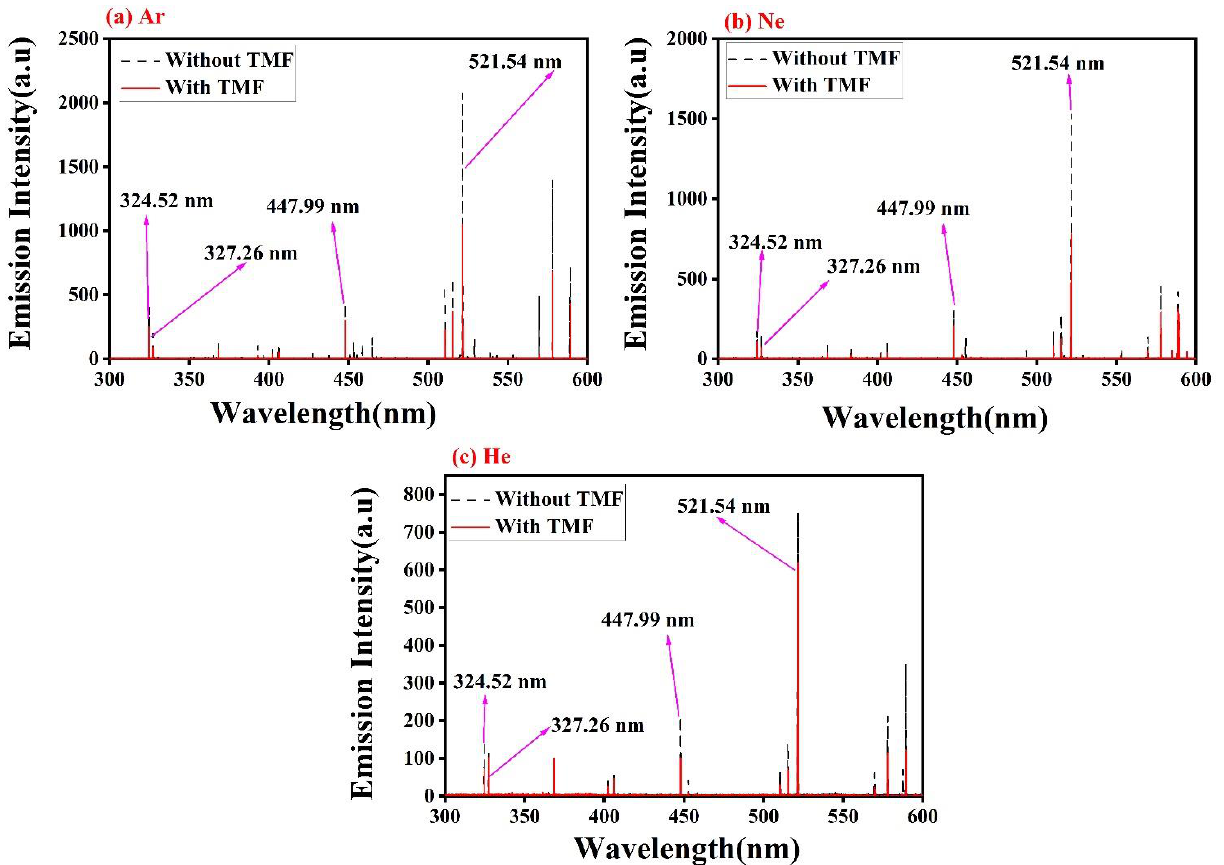
Figure 2. The optical emission spectra of selected Cu lines under 30 torr pressure of Ar, Ne, and He gas at 3.8 GW/cm 2 irradiance with and without TMF in the spectral range from 300 nm to 600 nm.